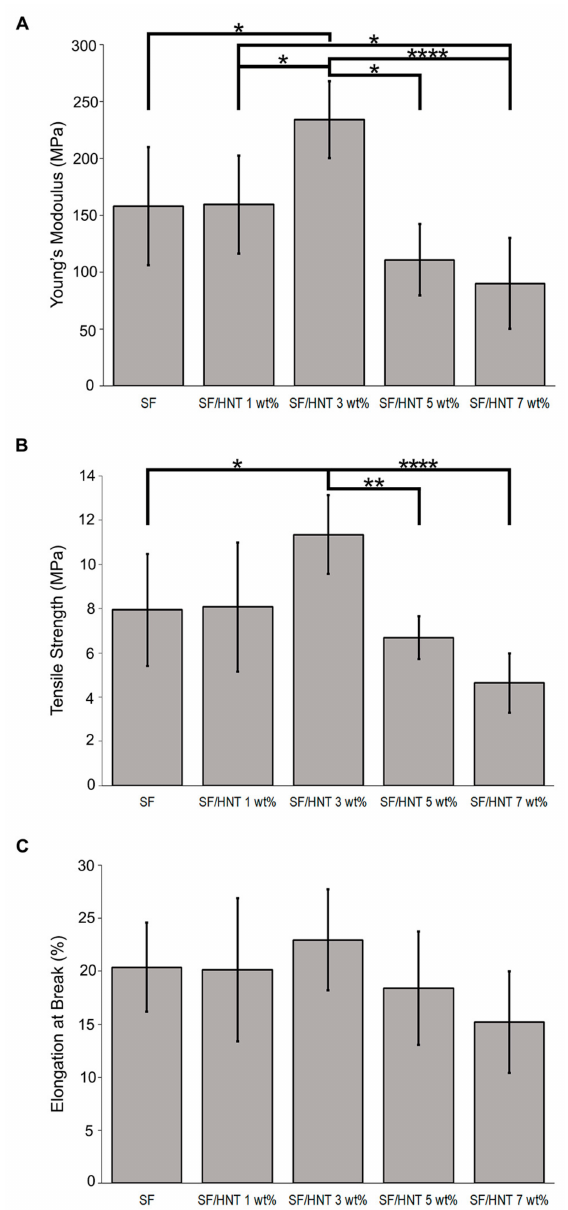
Figure 4. Mechanical properties of SF and SF/HNT composite scaffolds. ( A ) Young’s modulus, ( B ) tensile strength, and ( C ) elongation at break of SF. The analyses were performed on 10 repli- cates for each batch of scaffolds. Means ± SD are shown. Statistical analyses were ANOVA fol- lowed by Tukey’s test. * p ≤ 0.05, ** p ≤ 0.01, **** p ≤ 0.0001. Elongation at break data was not significantly